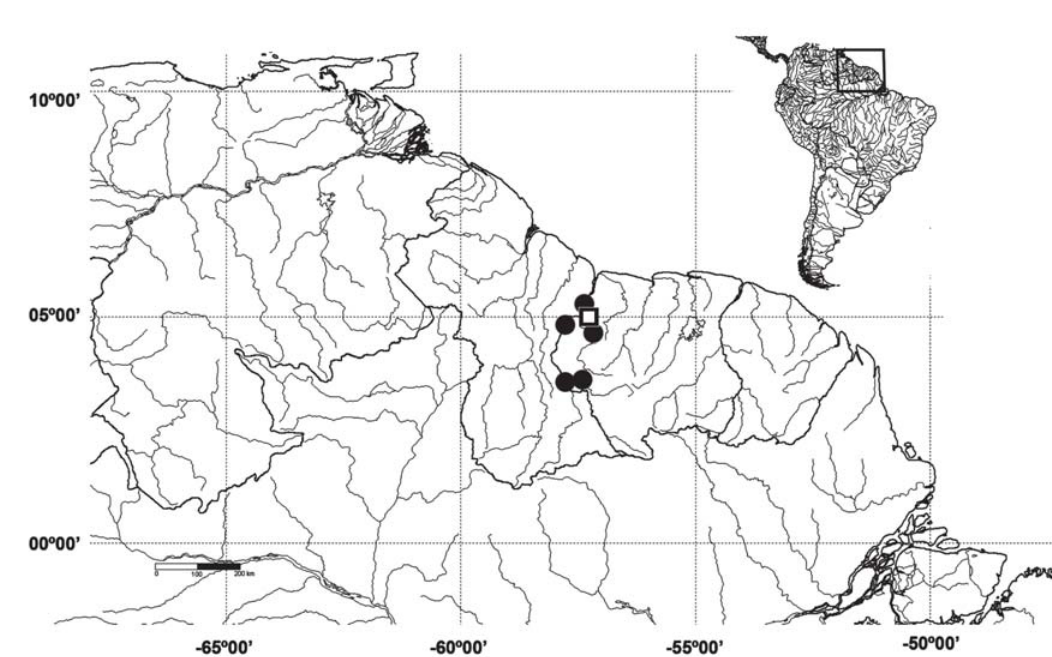
Fig. 9. Map depicting localities of specimens of Potamotrygon boesemani . Open square is the locality of holotype (Corantijn